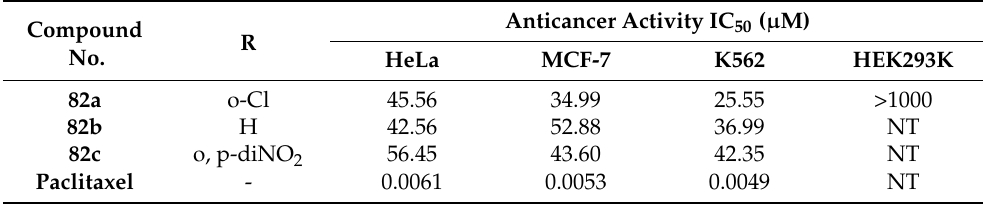
Table 68. In vitro cytotoxic activities of curcumin-pyrazole hybrid compounds 82 ( a – c ).